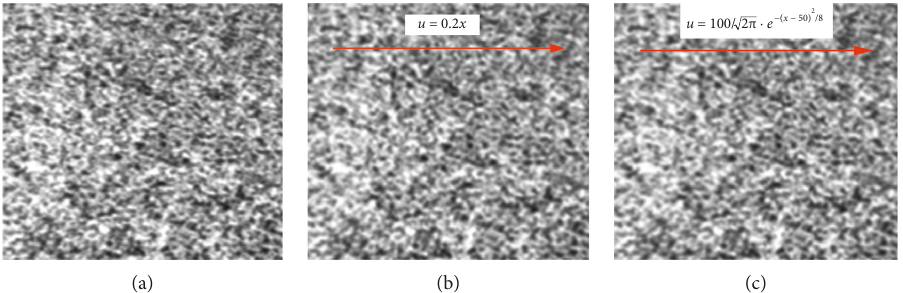
Figure 5: Images of simulation generates speckle. (a) Initial reference image. (b) Uniform deformation field. (c) Inhomogeneous de- formation field.